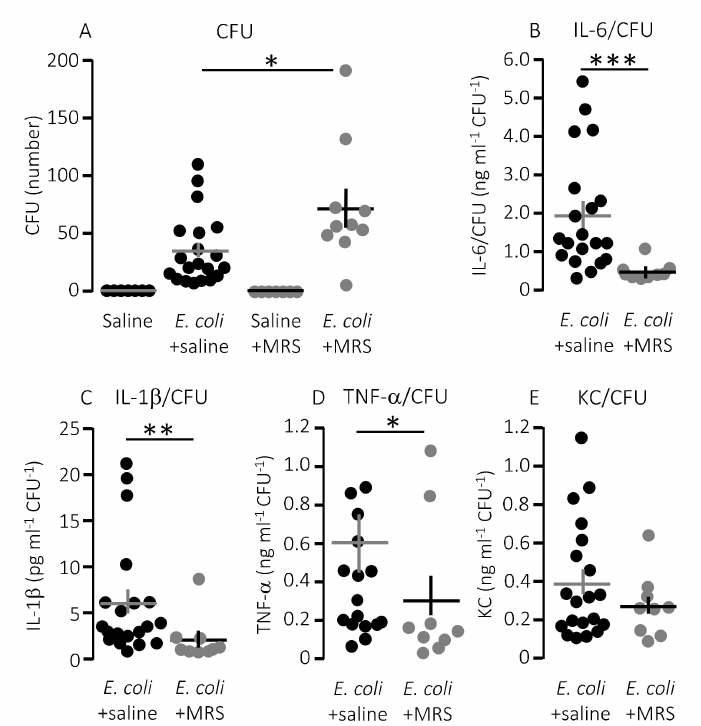
Figure 4. The cytokine response relative to the degree of infection inflicted by injection of HlyA-producing E. coli in the absence or presence of infusion of P2Y 1 receptor antagonist. ( A ) The number of colony forming units (CFU) from streaking out 5 µ L whole blood (diluted as described in methods) of mice infused with either control solution or MRS2500 (25.9 µ g / h) in the presence or absence of sepsis with HlyA-producing E. coli . (B–E) The cytokine [( B ) IL-6; ( C ) IL-1 β ; ( D ) TNF- α ; and ( E ) KC] response relative to the infection status represented by the number of colony-forming units. The data are given as single observations and mean ± S.E.M (saline n = 7, E. coli + saline n = 20, saline + MRS2500 n = 7, E. coli + MRS2500 (25.9 µ g / h) n = 10), * p < 0.05, ** p < 0.01, *** p <